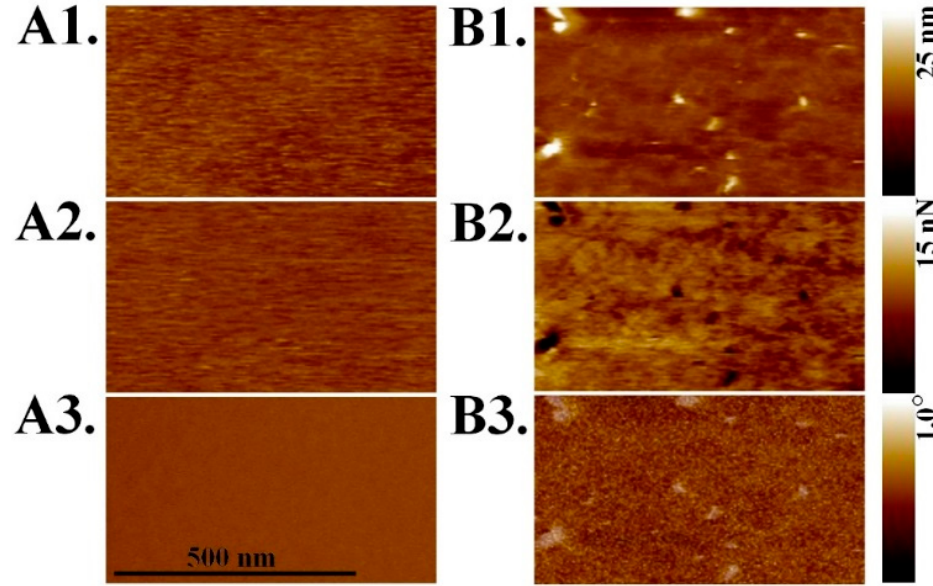
Figure 7. PF-MFM images of poly(APTAC) brushes ( A1 – A3 ) and poly(APTAC)+SPIONs brushes ( B1 – B3 ): 1. topography, 2. adhesion, 3. magnetic